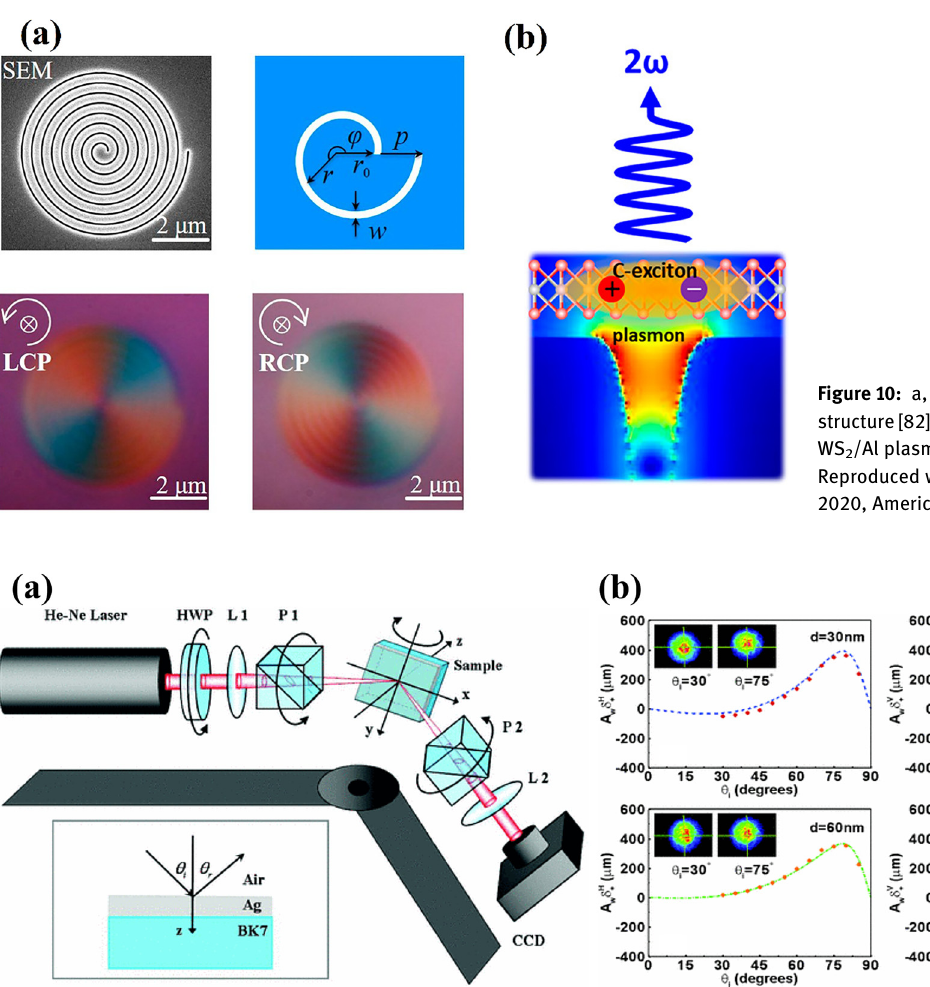
Figure 11: a, Experimental setup [116]; b, Ampli fi ed displacements of horizontal polarized (left column) and vertical polarized (right column) beam re fl ection on Ag fi lms of different thicknesses of 30 and 60 nm [116]. Reproduced with permission. Copyright 2012 American Physical